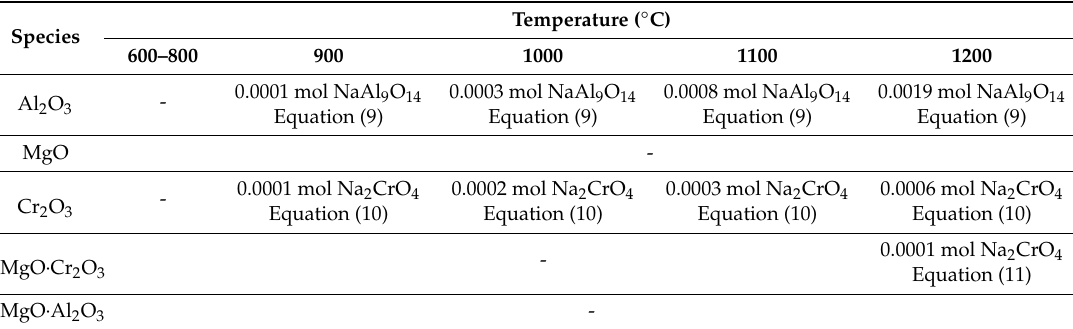
Figure 4. Gibbs free energy of the five corrosion reactions between NaCl and refractory materials at 600–1200 °C. Table 3. Predicted corrosion products and reaction equations of NaCl on refractory materials at 600–1200 °C.